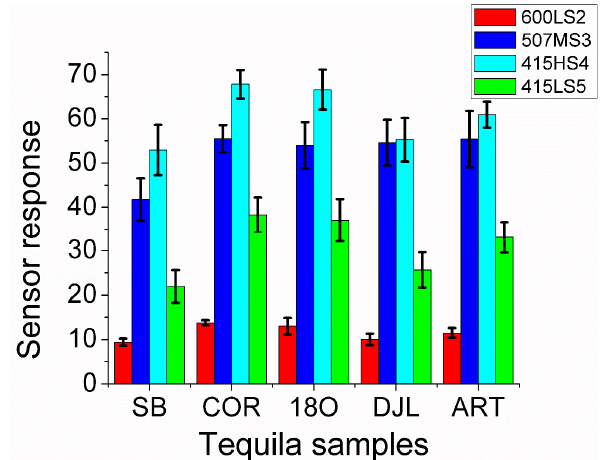
Figure 7. Average responses of the ZnO sensors for the different Tequila and Agave liquor samples. Sensor operating temperature was set to 200 °C. Beverage samples are labeled according to Section 2.